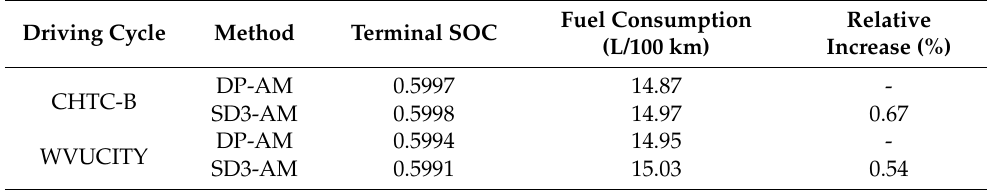
Table 5. Fuel consumption in simulation of initial SOC = 0.6.